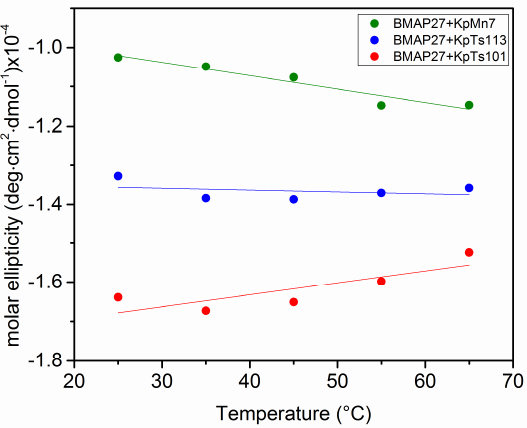
Figure 3. Increasing temperature effect on the BMAP-27 conformation in phosphate buffer in the presence of the investigated EPOLs. The CD ellipticity was measured at 222 nm. The EPOL concentrations were KpTs101 = 200 μM; KpTs113 = 198 μM; KpMn7 = 179 μM.